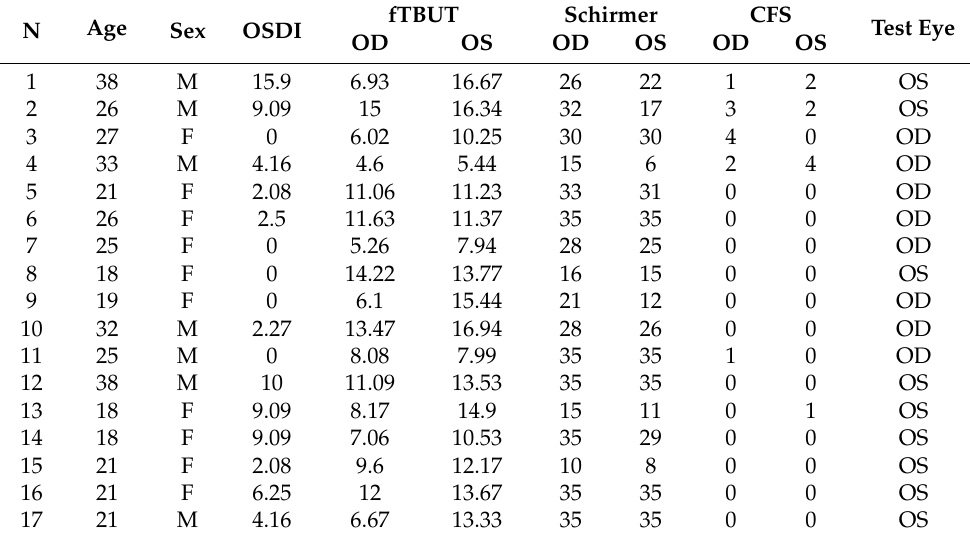
Table 1. Demographics detailing age and sex and clinical features, detailing OSDI score (r), fTBUT (second), Schirmer test values (mm of wetting in 5 min) and CFS grades (measured in